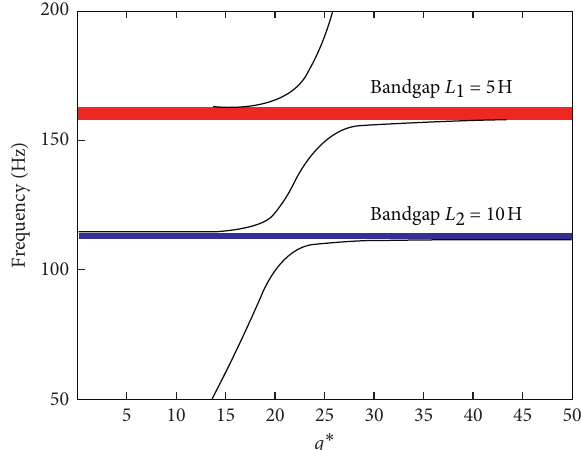
Figure 4: The locally resonant band structure of the metamaterial beam in pure inductance circuit when L